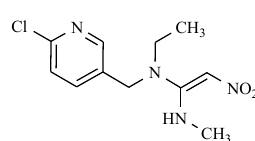
Figure 16. The chemical structure of nitenpyram.